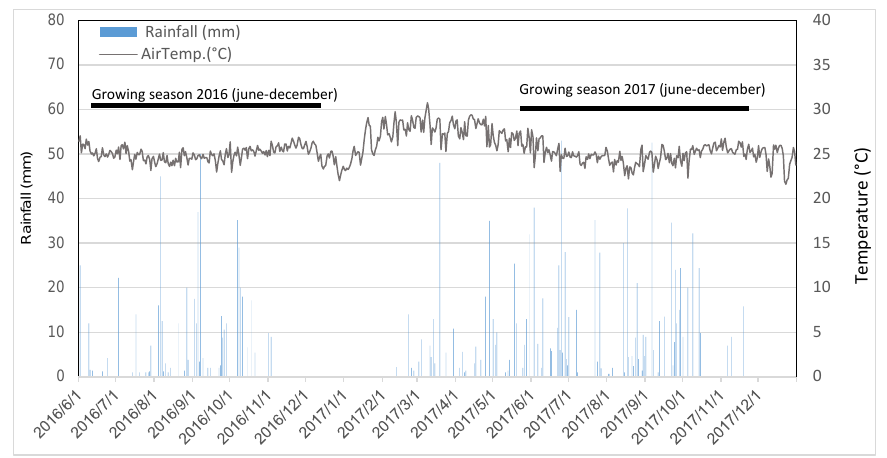
Figure 4. Daily rainfall (mm) and daily air average temperature (°C) during the 2016 and 2017 crop seasons at the experimental station.